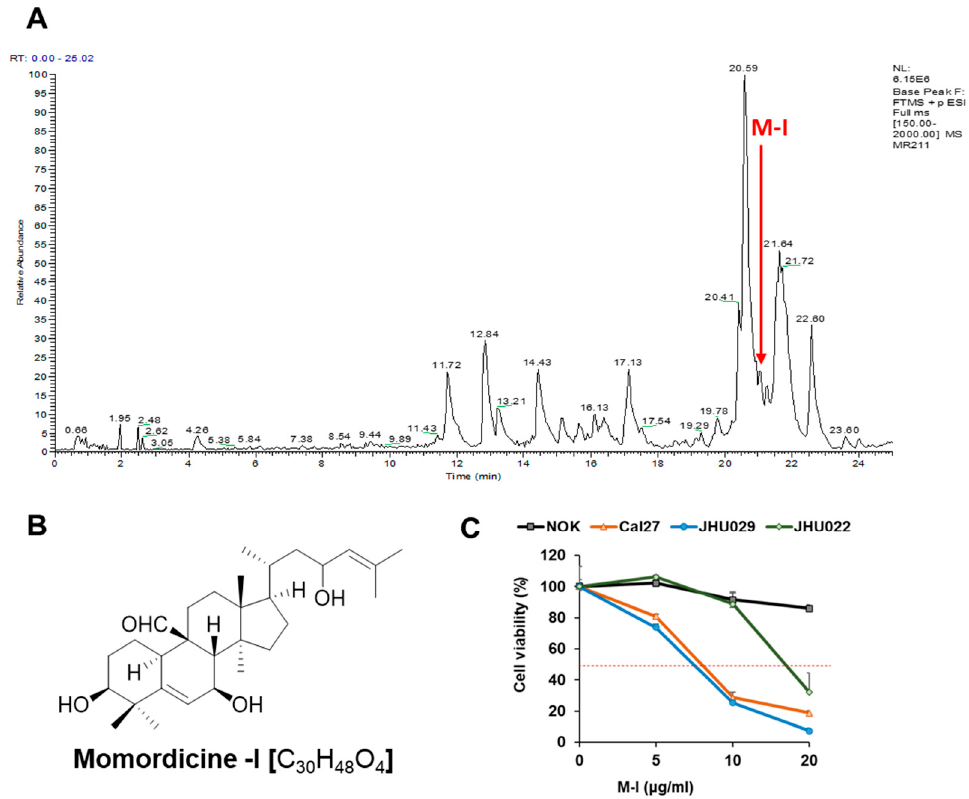
Figure 1. Mass-spectrometric analysis of bitter melon extract and identification of momordicine-I. ( A ) LC trace of bitter melon extract done by HRMS. The red arrow indicated the presence of momordicine-I (M-I) peak. ( B ) Chemical structure of momordicine-I. ( C ) HNC cells (Cal27, JHU029, JHU022) and control NOK were treated with M-I at different concentration for 48 h, and cytotoxicity assay was performed. Small bar indicates standard